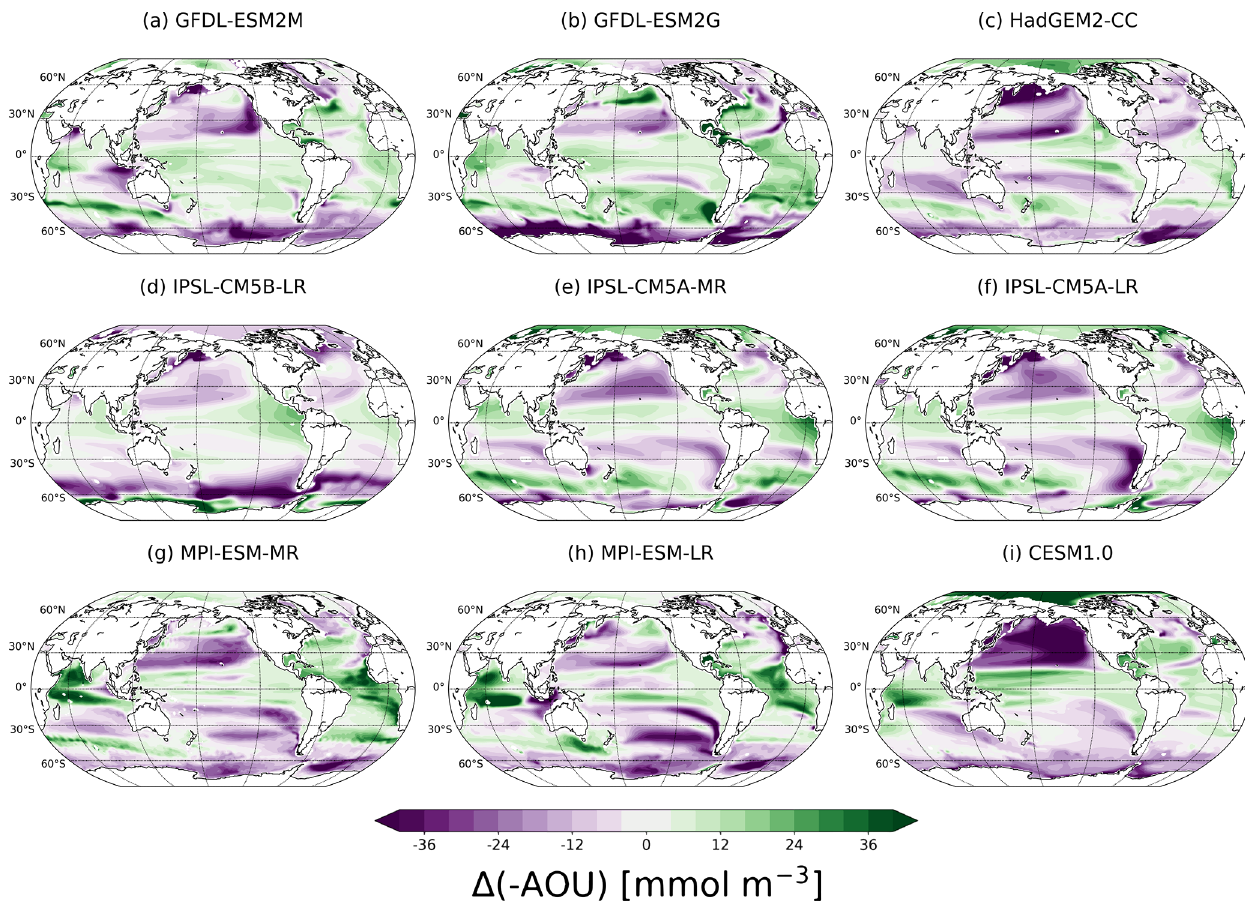
Figure 8. Anthropogenic changes (2070–2099CE minus 1861–1959CE) in [-AOU] in the thermocline for each model.